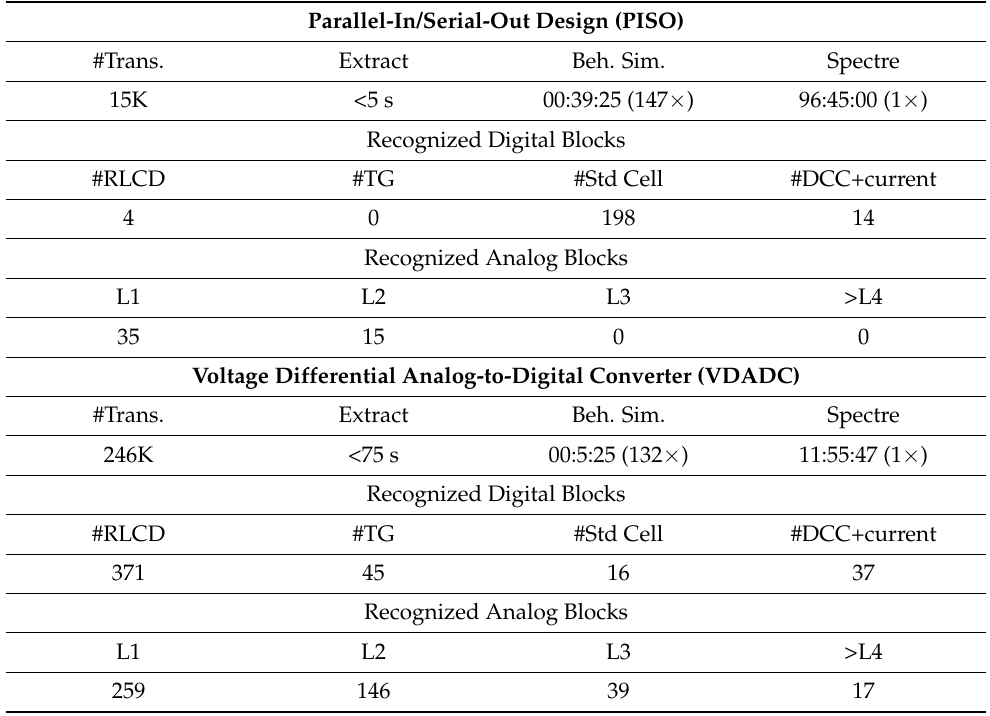
Table 2. Structure recognition results for industrial cases. Parallel-In/Serial-Out Design (PISO) #Trans. Extract Beh.